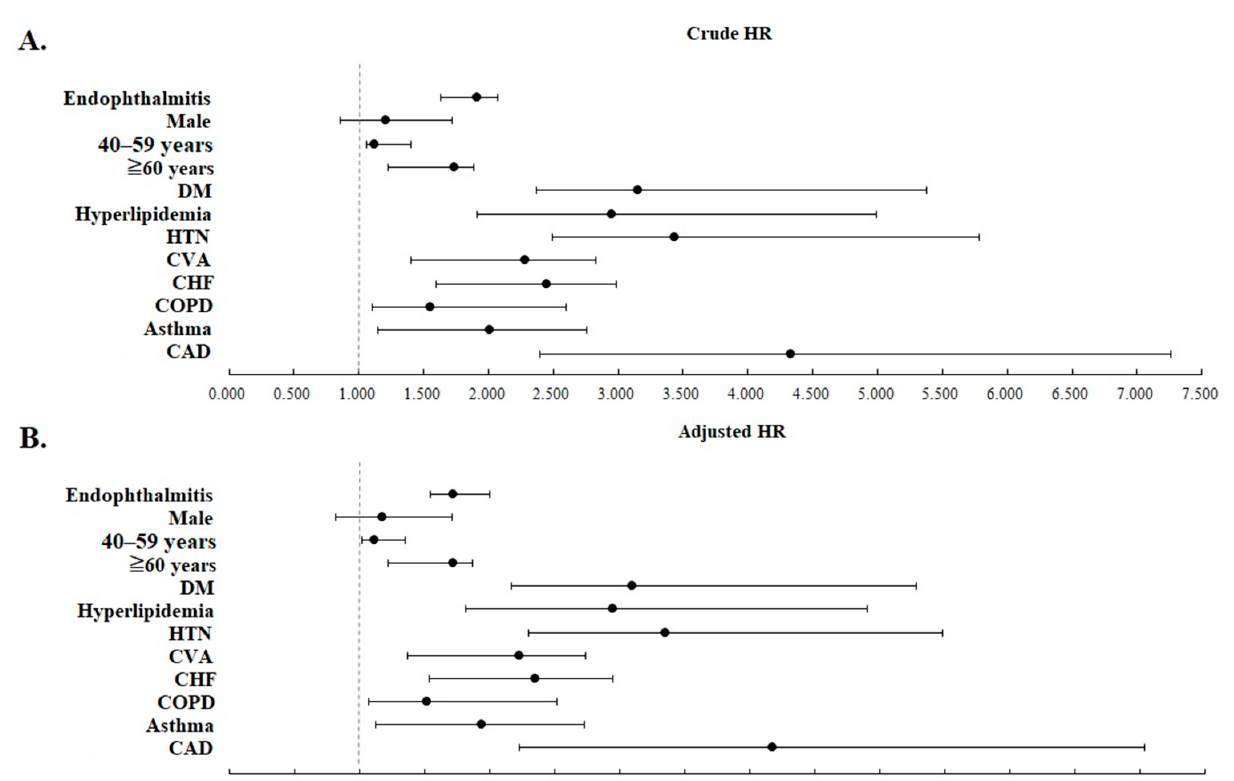
Figure 4. Forest plots of the crude ( A ) and adjusted ( B ) HRs of clinical variables analyzed in Table 2. All variables listed in Table 2 were adjusted in adjusted HR.